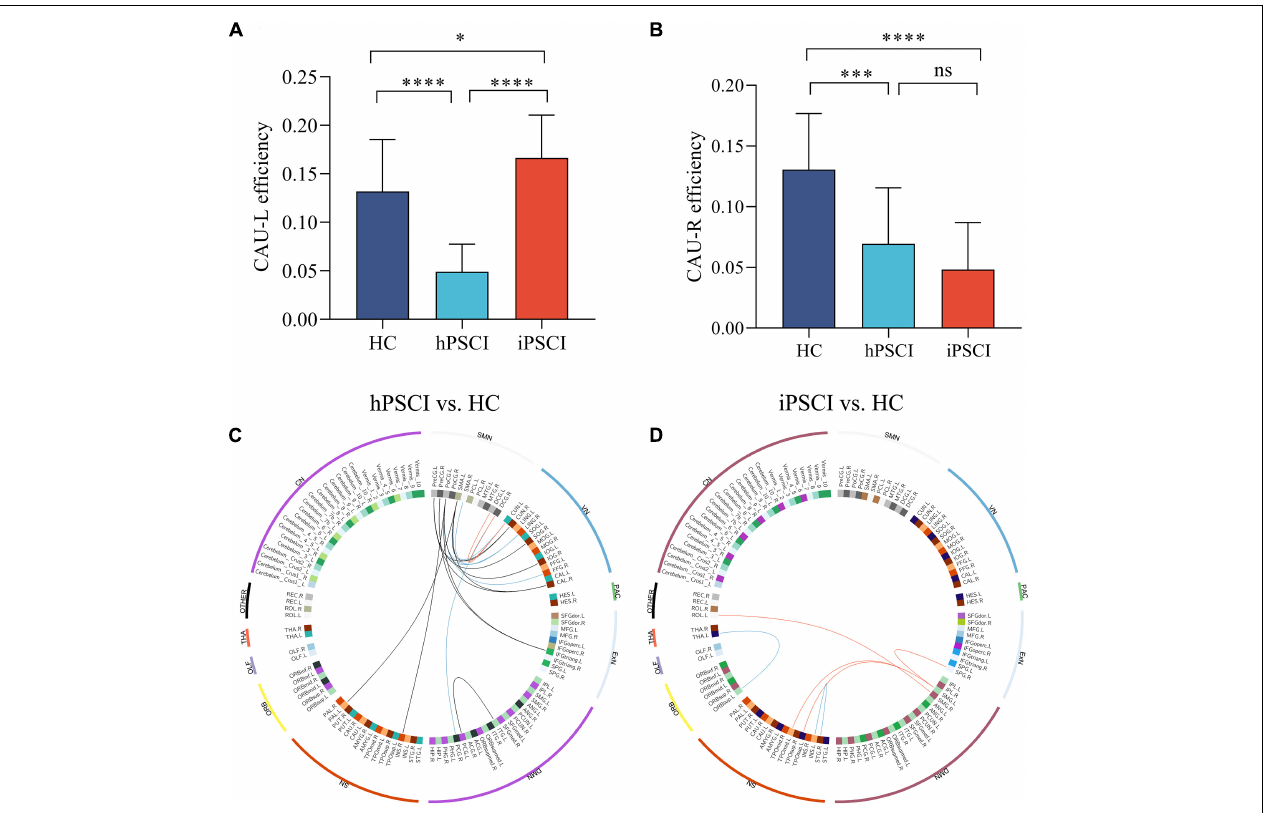
FIGURE 3 | The alteration in nodal efficiency in PSCI versus HC. (A) CAU_L efficiency. (B) CAU_R efficiency. Ns, not significant; ∗ p < 0.05; ∗∗∗ p < 0.001; ∗∗∗∗ p < 0.0001. The positive correlation between the decrease in functional connectivity and clinical performance. (C) Decreased feeder connections were positively correlated to MMSE (red lines) and MoCA (blue lines), and decreased local connections were positively correlated to MoCA (black lines) in hPSCI patients versus HC. (D) Decreased local connections were positively correlated to MMSE (red lines) and MoCA (blue lines) in iPSCI patients versus HC. CAU_L, left caudate; CAU_R, right caudate; HC, healthy controls; hPSCI, hemorrhagic post-stroke cognitive impairment; iPSCI, infarct post-stroke cognitive impairment; MoCA, Montreal Cognitive Assessment; MMSE, Mini-Mental State Examination; ORB, orbitofrontal cortex; SN, salience network; DMN, default-mode network; ExN, external frontoparietal network; PAC, primary auditory cortex; VN, visual network; SMN, sensorimotor network; CN, cerebellum network; THA, thalamus; OLF, olfactory